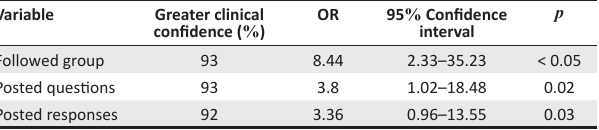
TABLE 2: Increased clinician confidence in managing patients and levels of group engagement. Variable